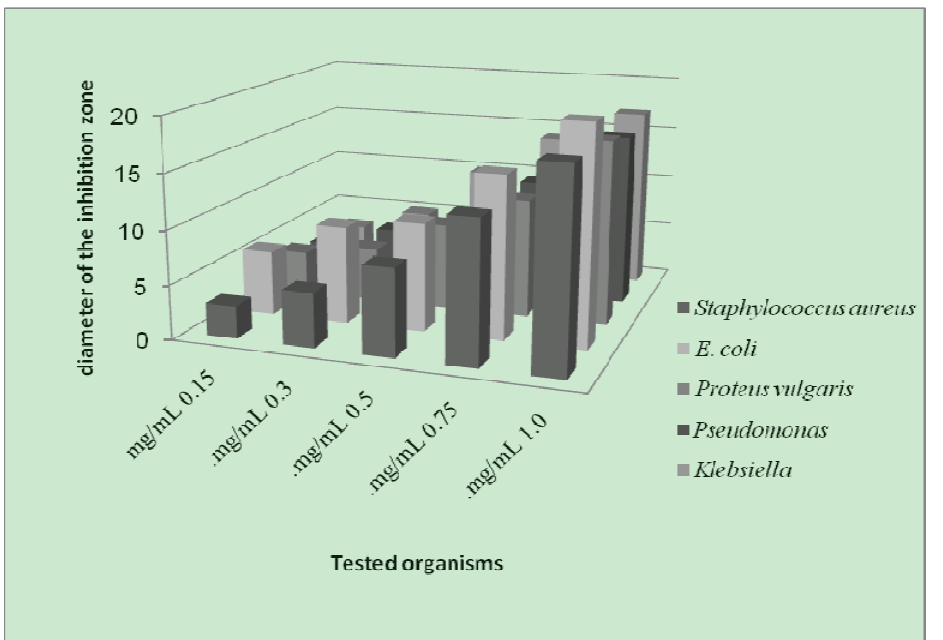
Figure 4. Effect of the Cr-complex toward test organisms.